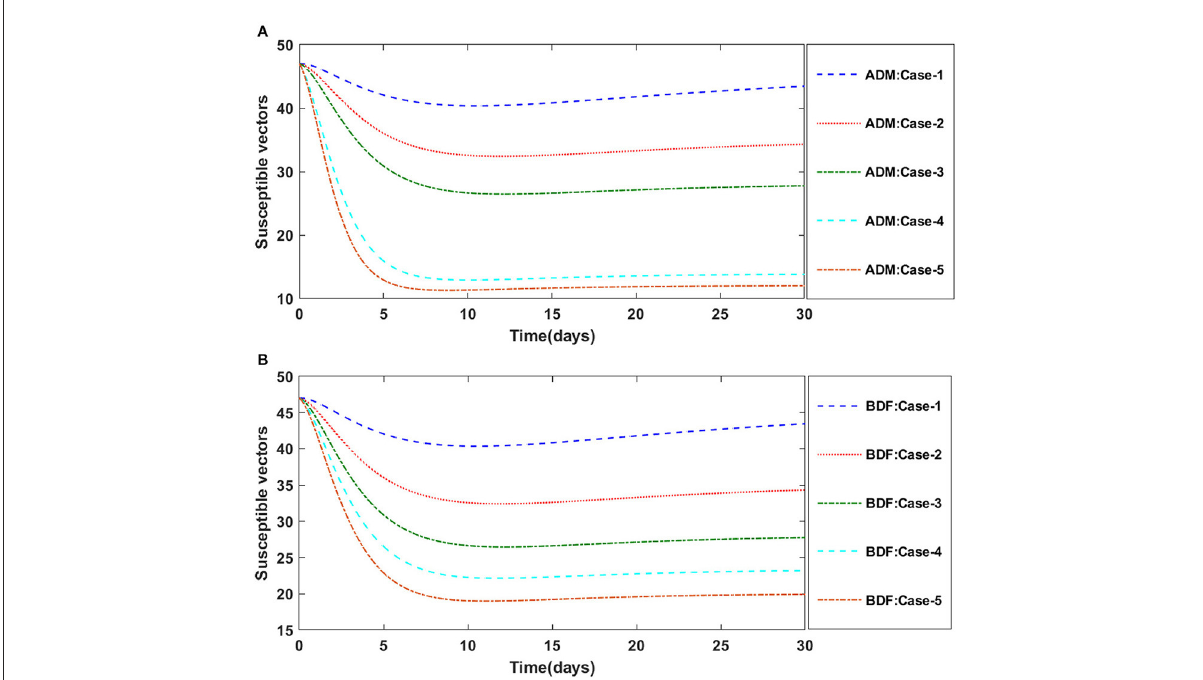
FIGURE4 (A) Dynamics of susceptible vectors for the varition in γ 1 using ADM for model A. (B) Dynamics of susceptible vectors for the varition in γ 1 using BDF for model A.